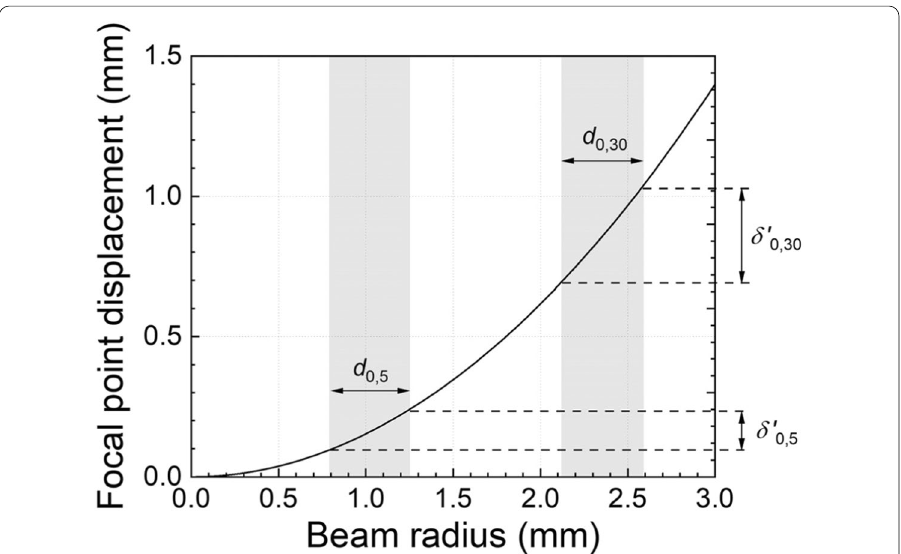
Fig. 3 The SA-induced focal point displacement (relative to the nominal focal position) as a function of beam radius at the lens L2. The gray zone shows the ring widths d p,m of certain modes. Their intersection with the SA curve is indicative of the effect that SA has on the beam (the calculated fundamental beam radius is 600 μm and the lens L2 is a plano-convex N-BK7 lens with f 33.9 mm at 1064 =